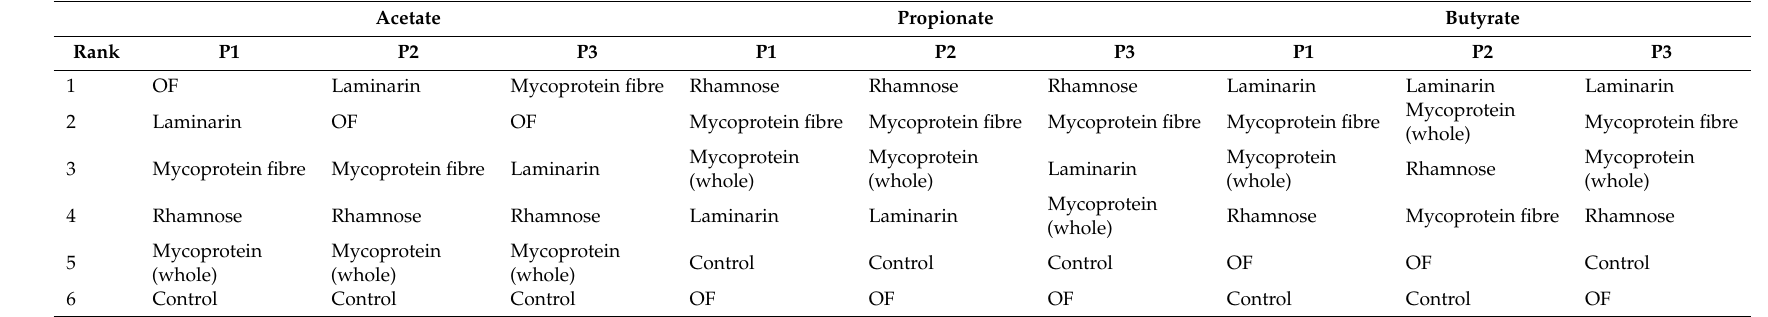
Table 2. Ranking of SCFA production in in vitro cultures for each stool